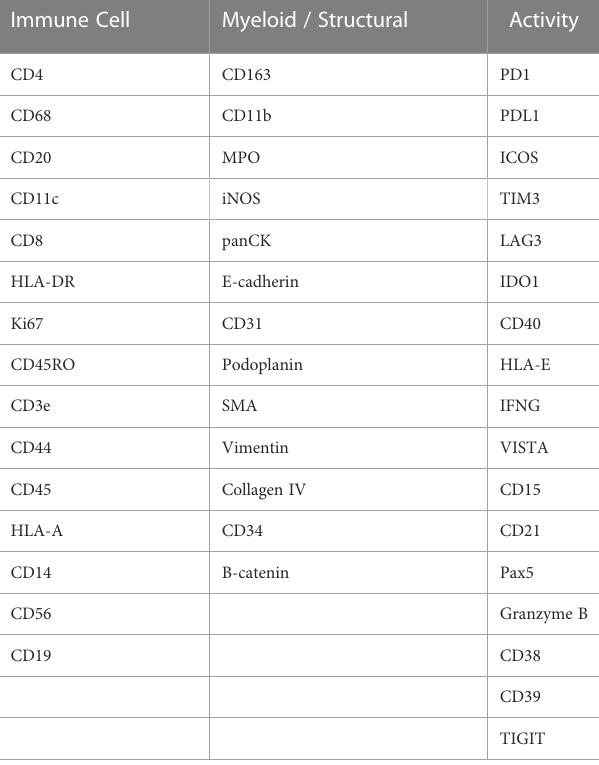
TABLE 3 Akoya Biosciences PhenoCycler-Fusion custom Immuno- oncology